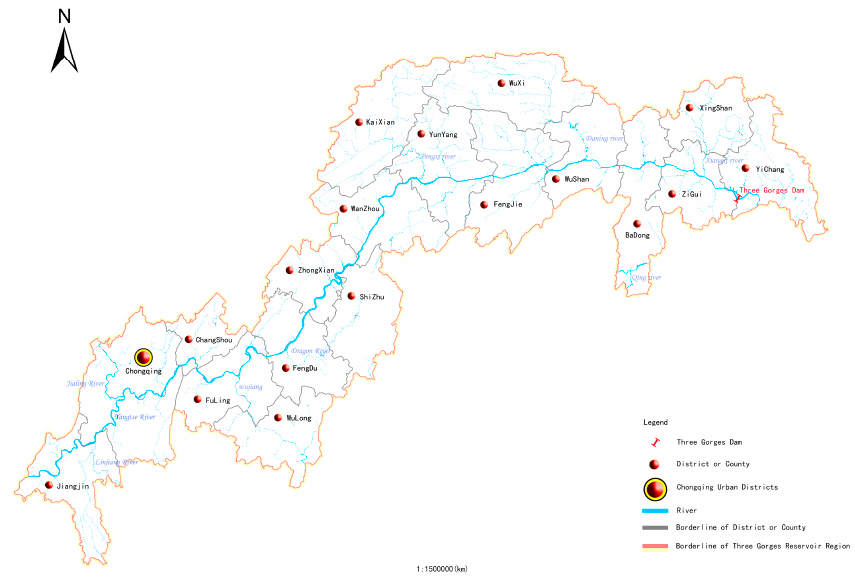
Figure 1. Administrative Map of the Three Gorges Reservoir Area.